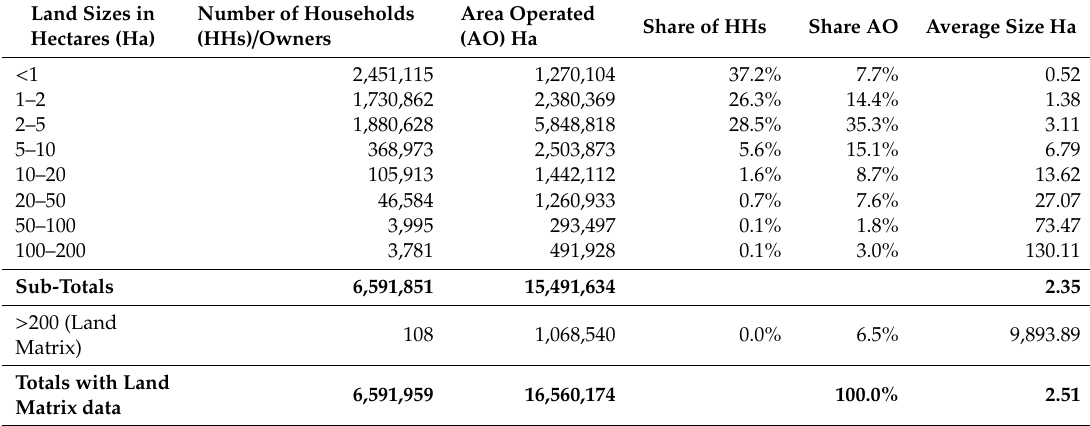
Table 2. Farm land distribution in Tanzania 2013. (Lowder, Bertini, Karfakis and Croppenstedt [103] calculated using LSMS household survey data from the World Bank, plus authors calculation of average farm sizes and addition of figures from the Land Matrix